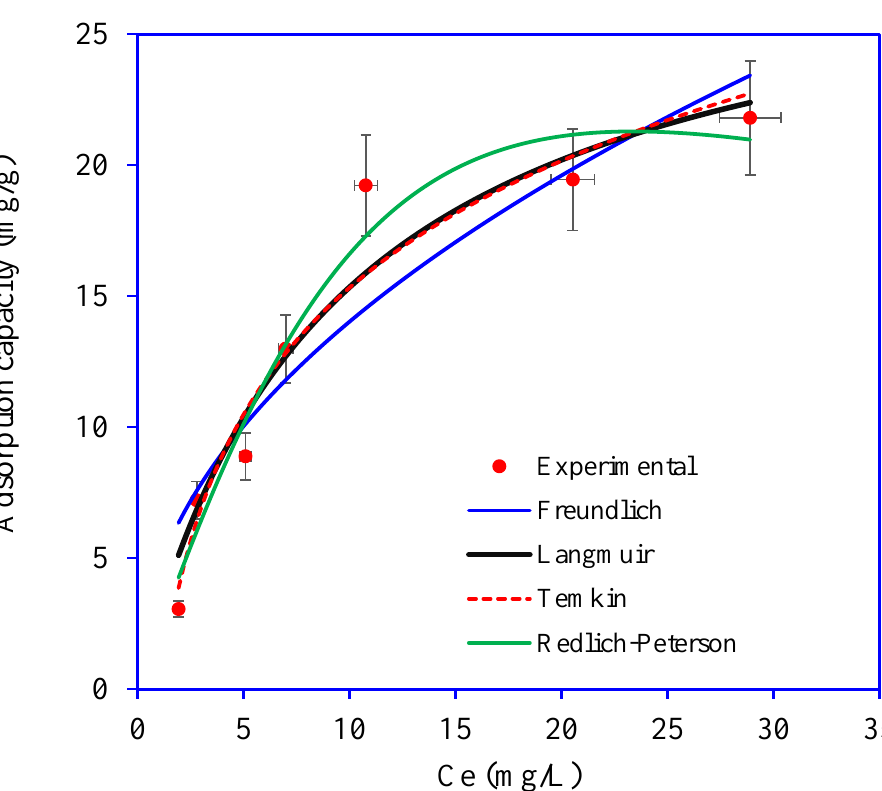
Figure 10. Plot for OTC adsorption isotherms onto Ni 3 S 4 /Ag 2 S/TiO 2 /CA aerogel. (aerogel mass: 0.03 g, OTC volume: 30 mL, time: 180 min, pH: 6).